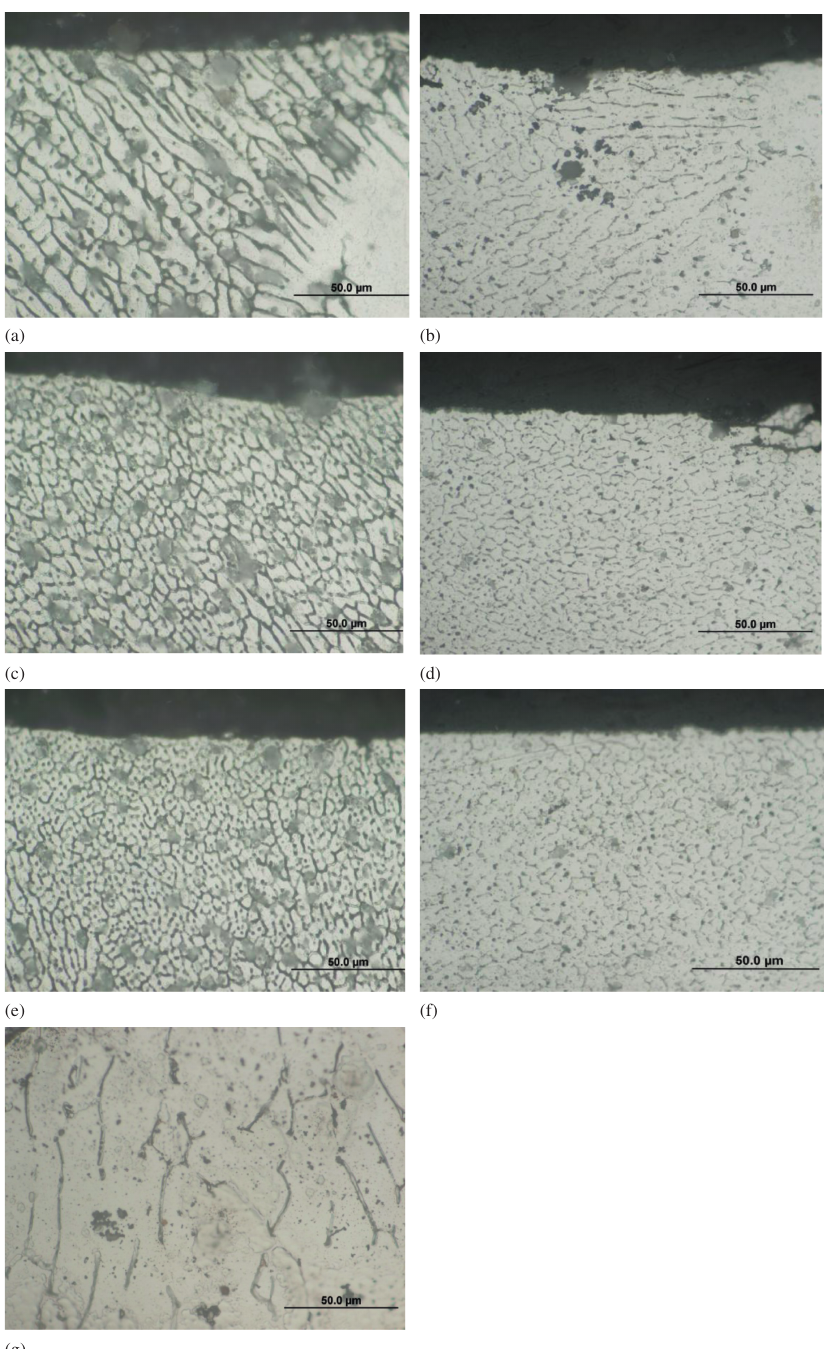
Figure 5: Microstructure of laser-melted layer under air cooling: (a) interface between melted layer and as-received composite, (c) middle of melted layer and (e) top of melted layer; laser-melted layer under liquid nitrogen cooling, (b) interface between melted layer and as-received composite, (d) middle of melted layer and (f) top of melted layer; and (g)